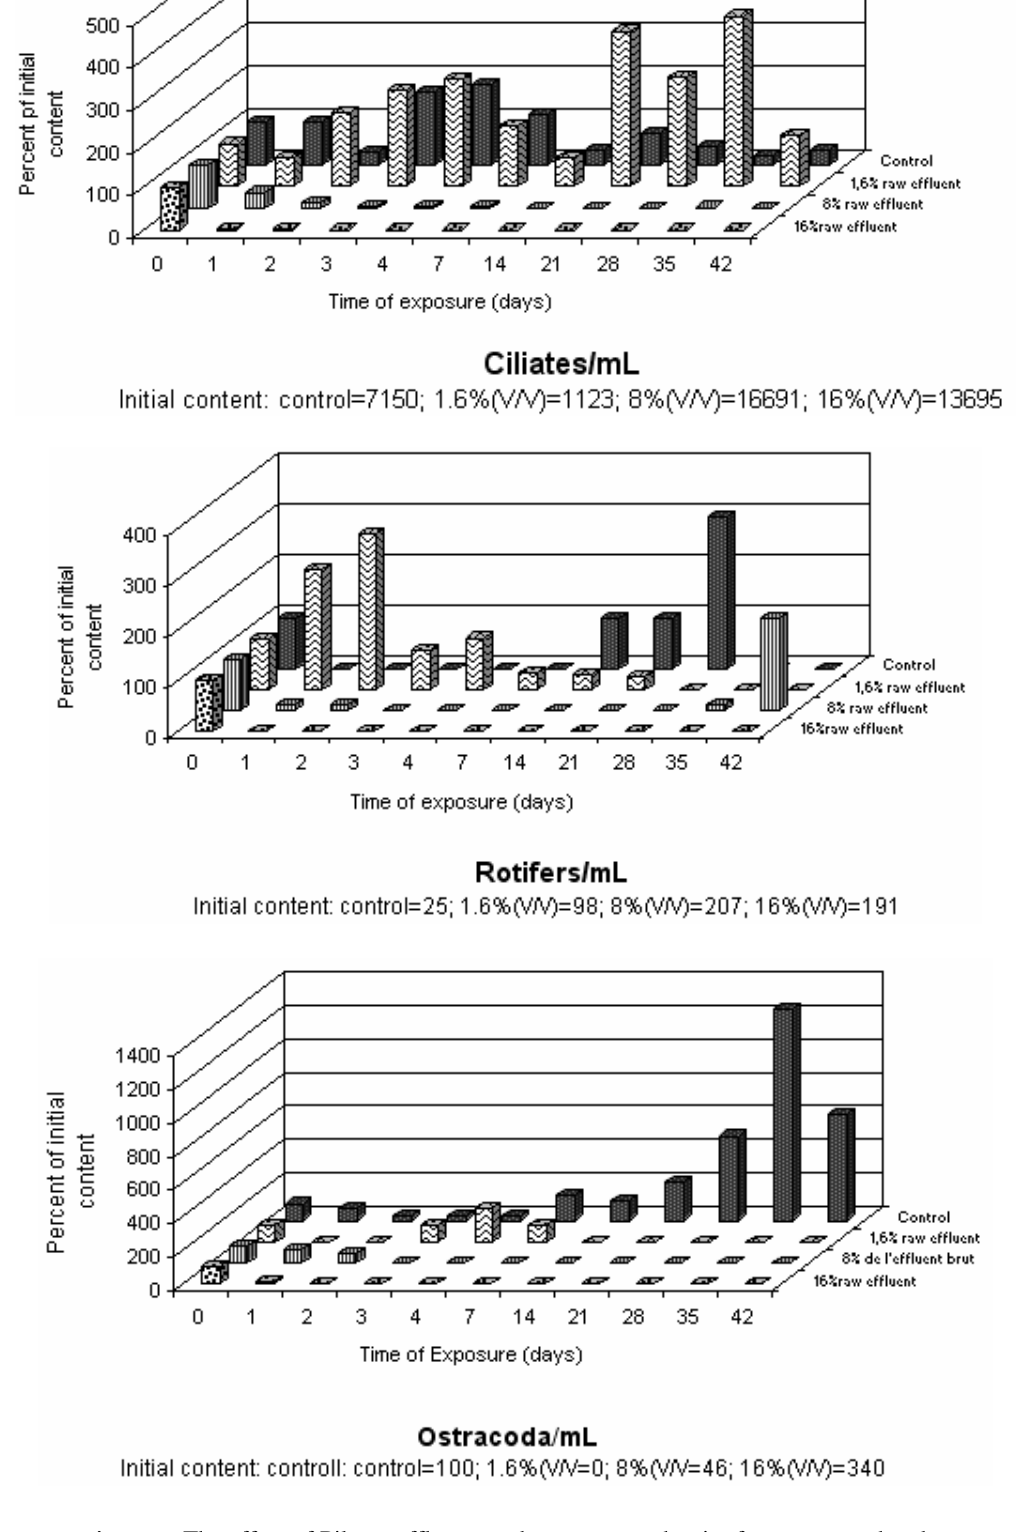
Figure 3: The effect of Pilcam effluent on the protozoan density from untreated and treated